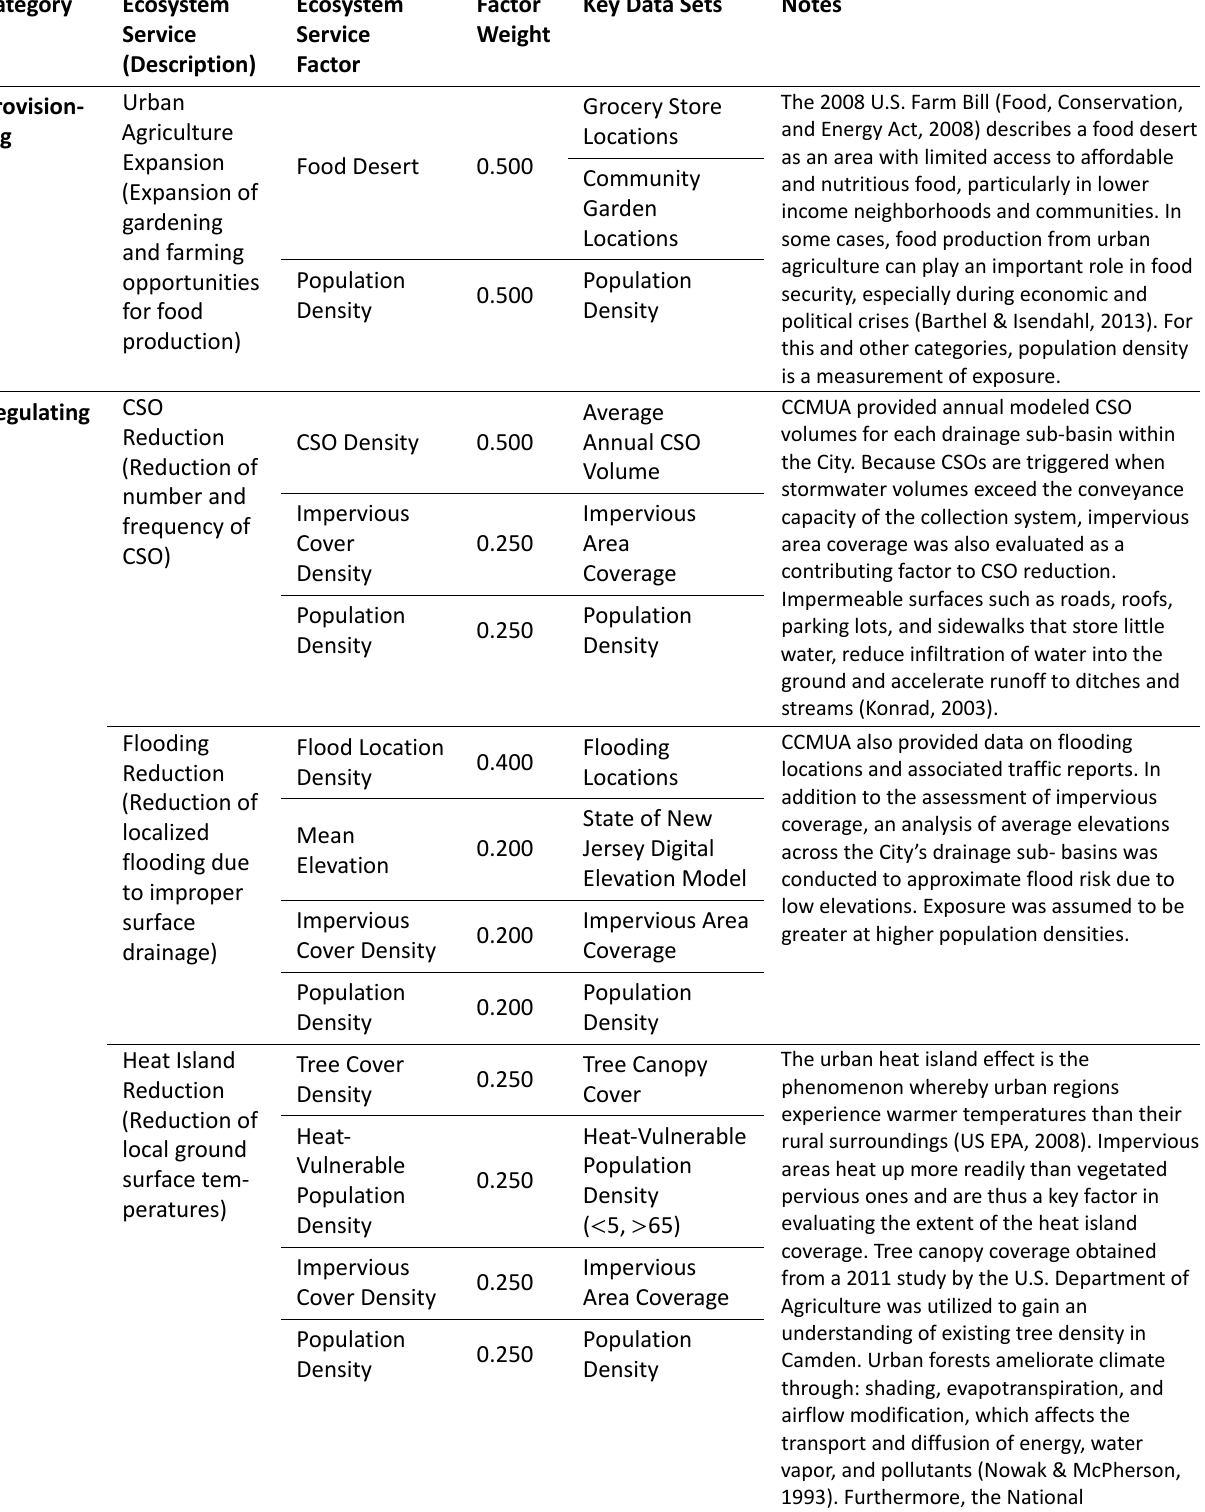
Table 1. Phase one evaluation of ecosystem services.